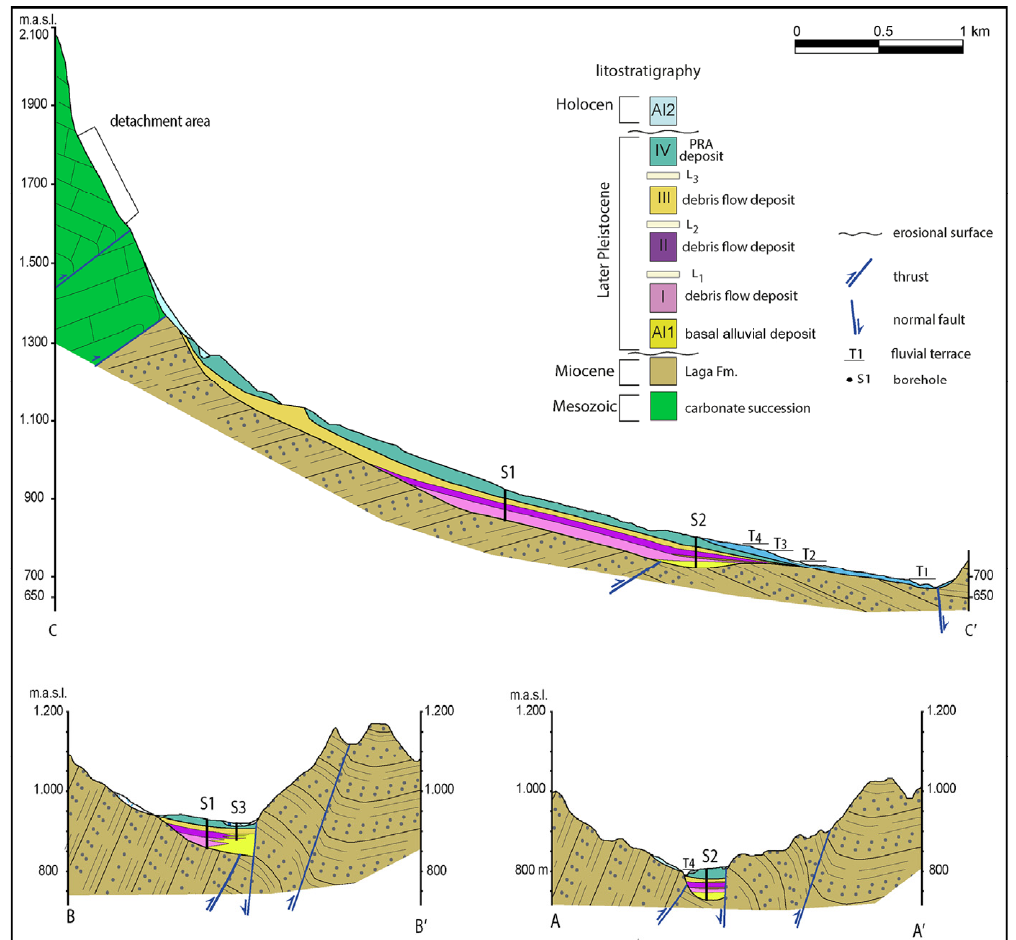
Figure 7. Geological cross sections cutting the S1, S2, and S3 boreholes.